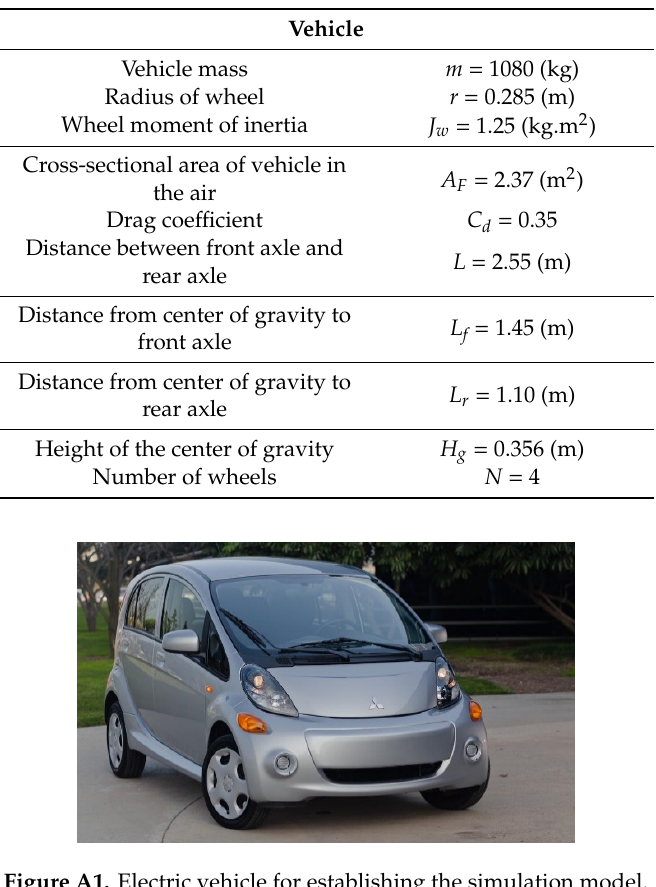
Table A1. Specification of the vehicle model.